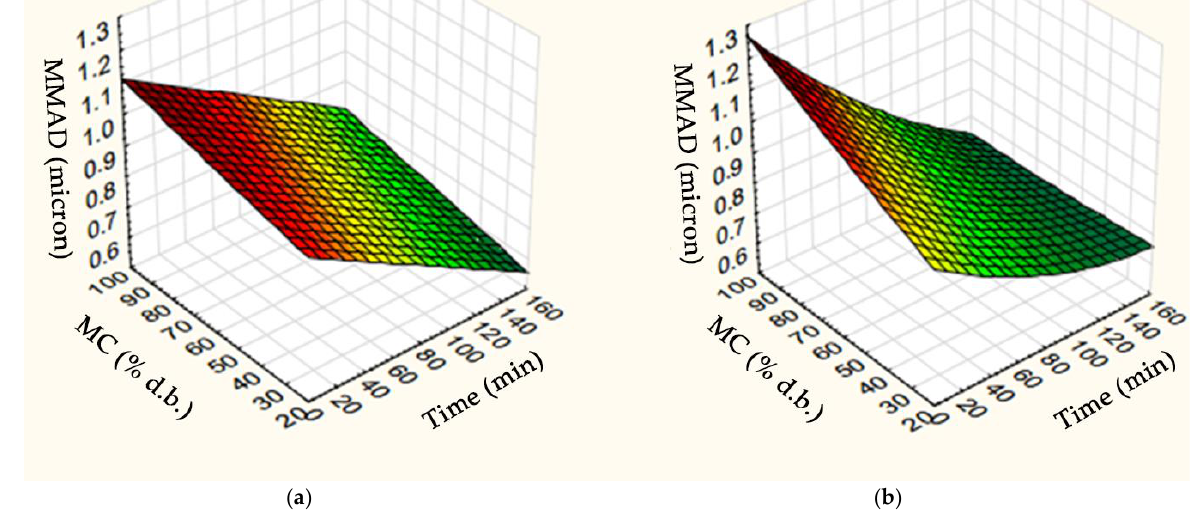
Figure 6. MMAD values’ 3D surface plots by the first- and second-degree models: ( a ) First-degree model; ( b ) Second-degree model. Table 2. Coefficient values of first- and second-degree models of MMAD prediction.